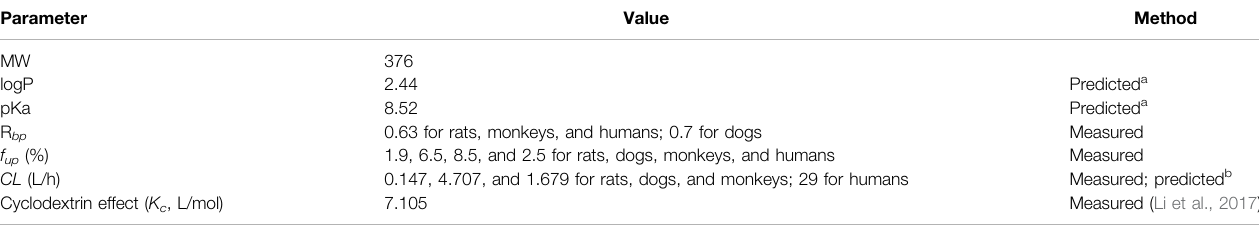
TABLE 3 | Physicochemical and ADME parameters of ST-246 used for PBPK model.